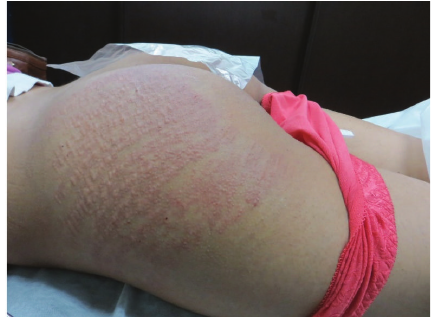
Figure 6: Immediate erythema at the site of treatment in a patient in FMR + CO 2